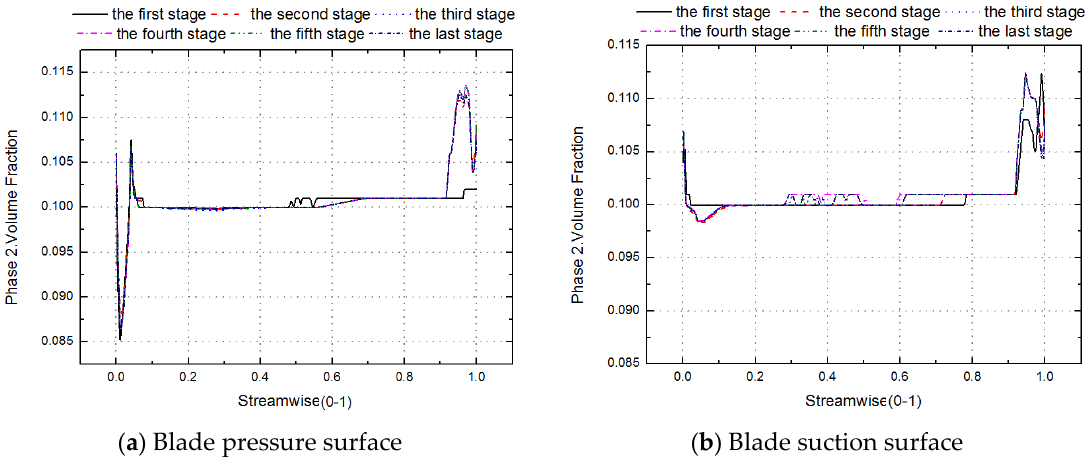
Figure 12. The distribution law of the GVF from the inlet to the outlet at the height of 0.2 times the blade height.